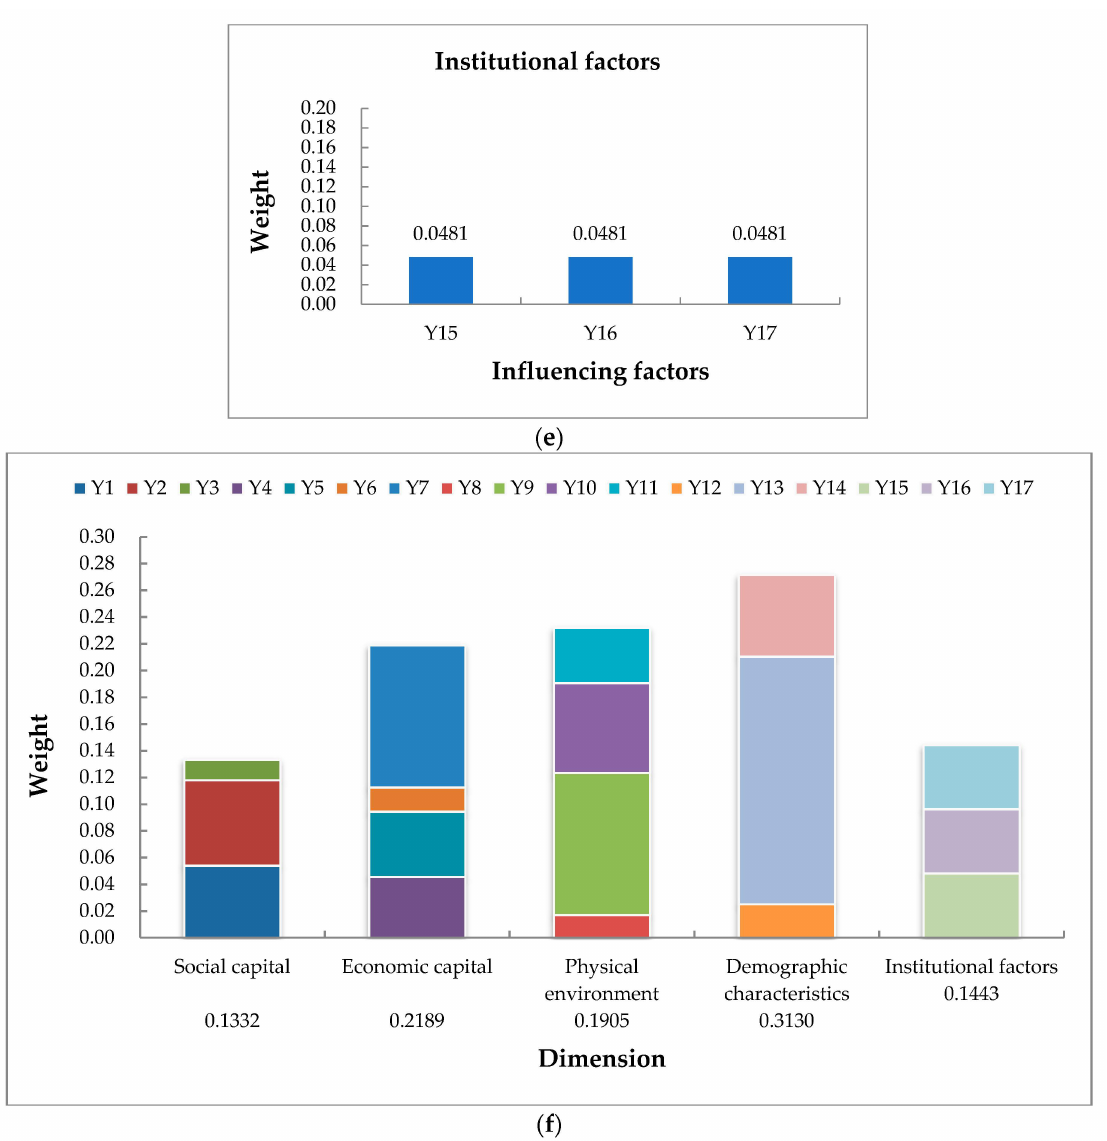
Figure 6. The weight of influencing factors of each dimension. ( a ) Social capital dimension; ( b ) economic capital dimen- sion; ( c ) physical environment dimension; ( d ) demographic characteristics dimension; ( e ) institutional factors dimension; ( f ) comparison of each